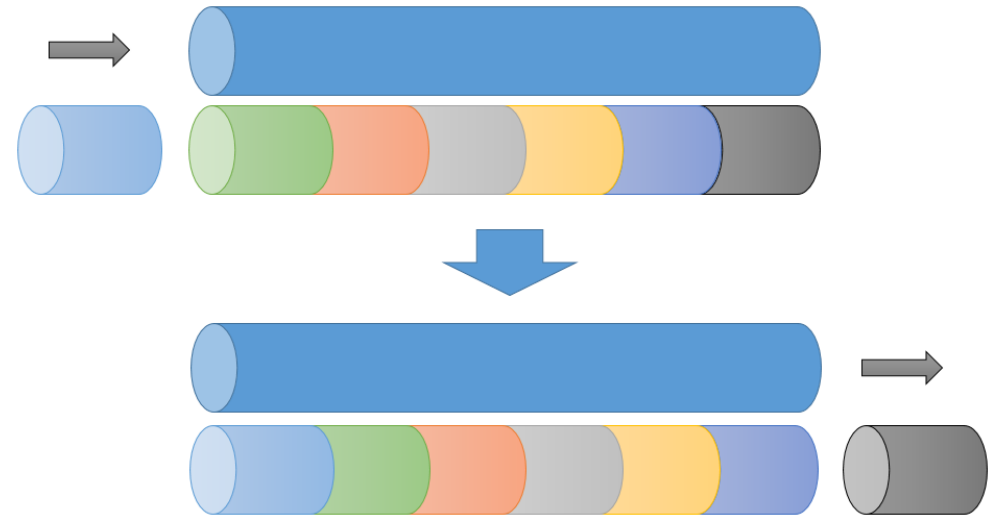
Figure 2. Element model: the principle of volume elements moving through the pipe system. The model includes two updates for the elements: (1) the contained volume; as the element passes by houses, flows to the houses are subtracted from the volume by (1). (2) Heat loss to the environment [13]; as an element moves through a pipe section, heat is lost as (2), and illustrated in Figure 3.